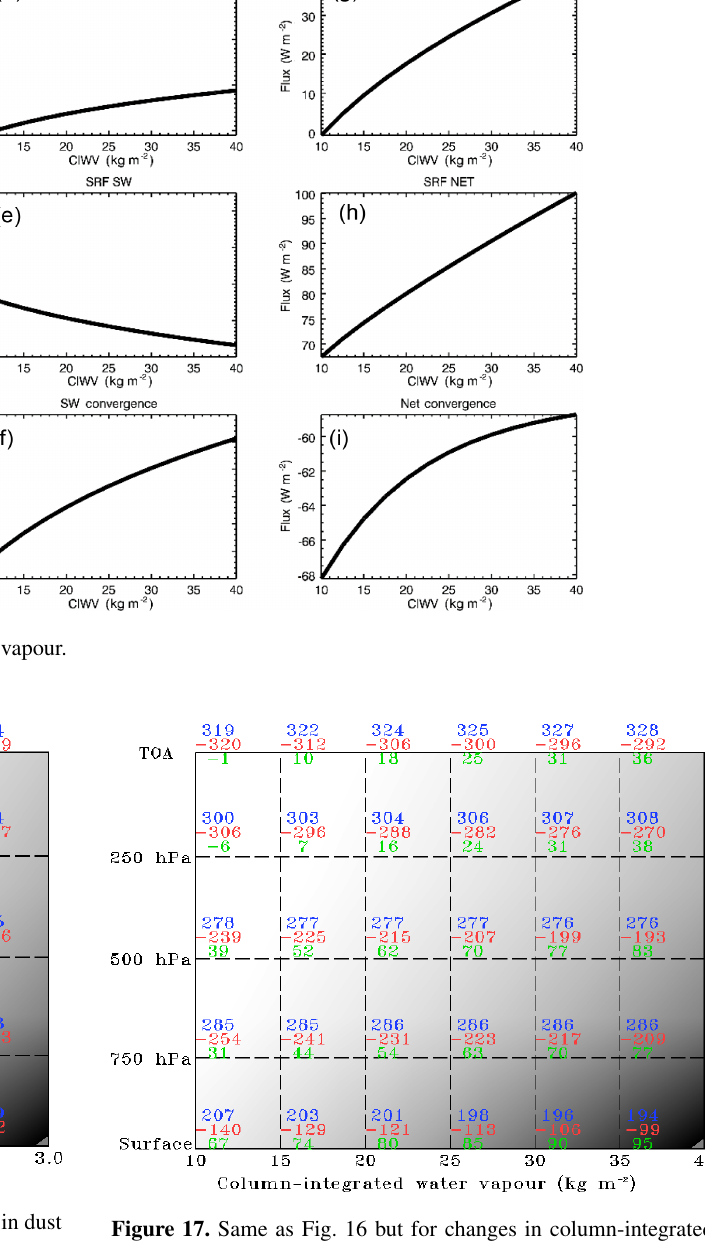
Figure 17. Same as Fig. 16 but for changes in column-integrated water